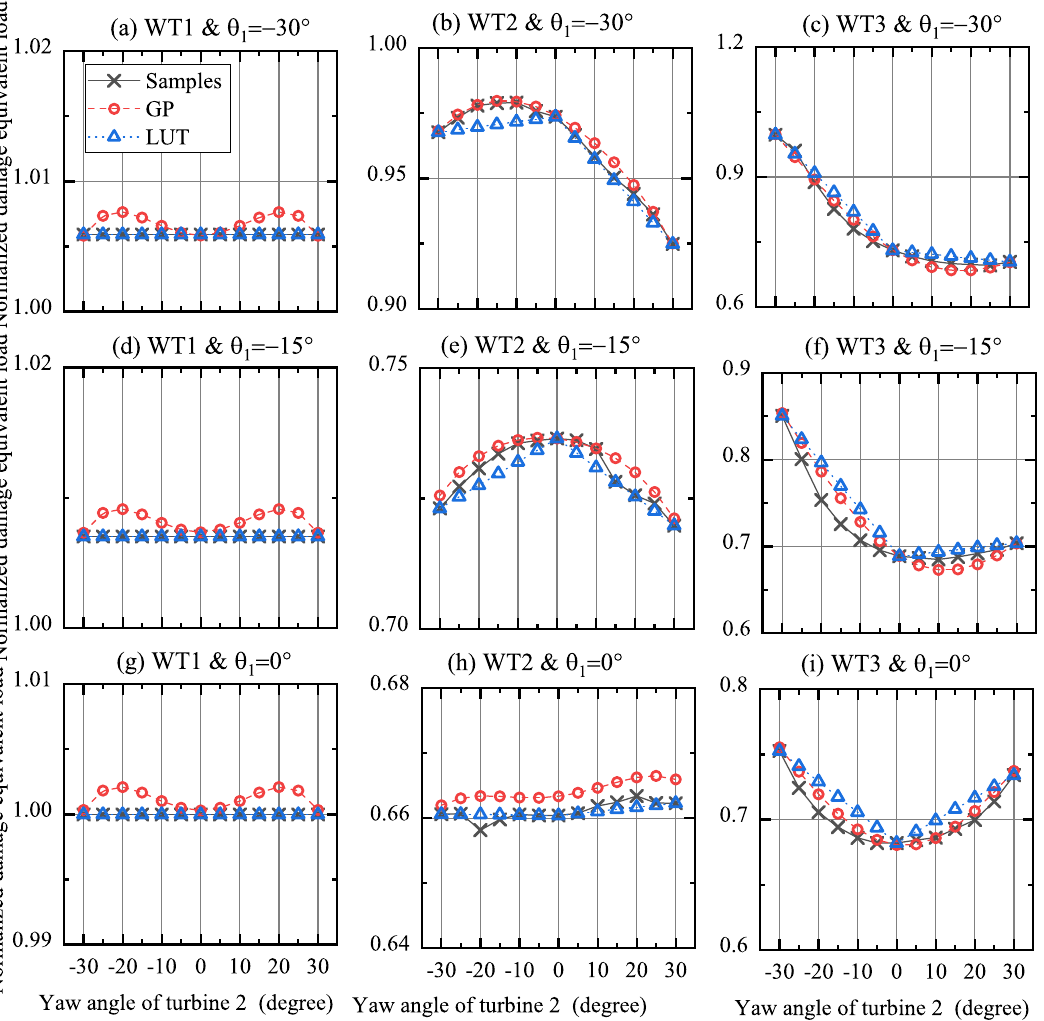
Figure 14. Prediction of normalized damage equivalent load at blade root edgewise moment under 9 m/s wind speed and 5% turbulence